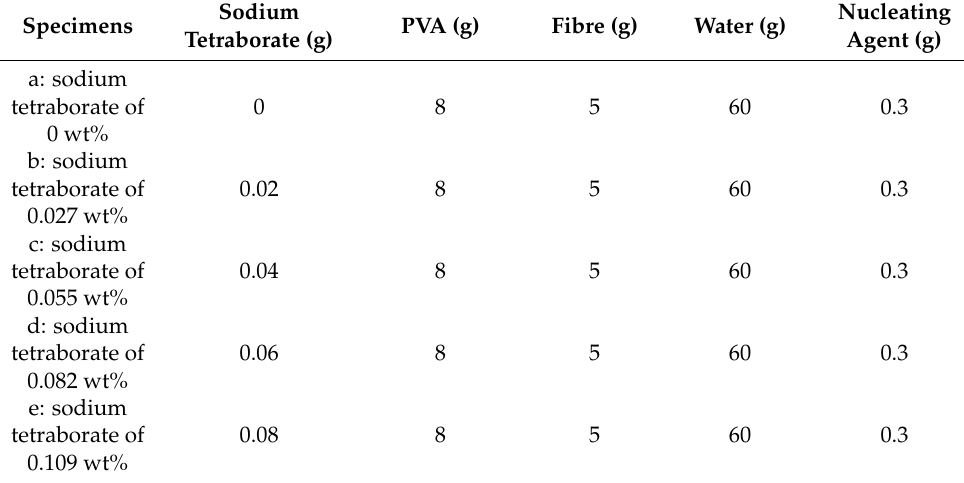
Table 2. Formulations of composites with different sodium tetraborate